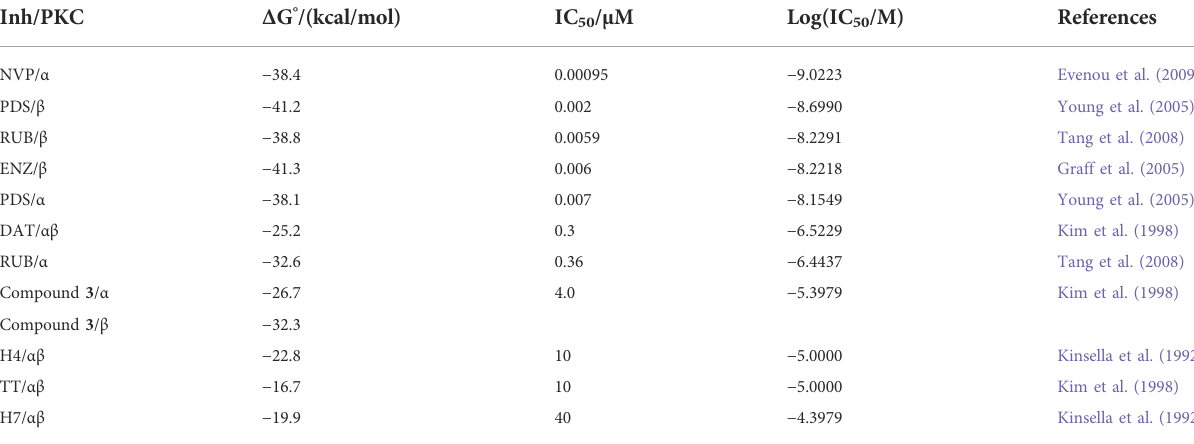
TABLE 2 Summary of the Δ G b ° from the MD simulations and experimental IC 50 of each inhibitor against each isozyme.